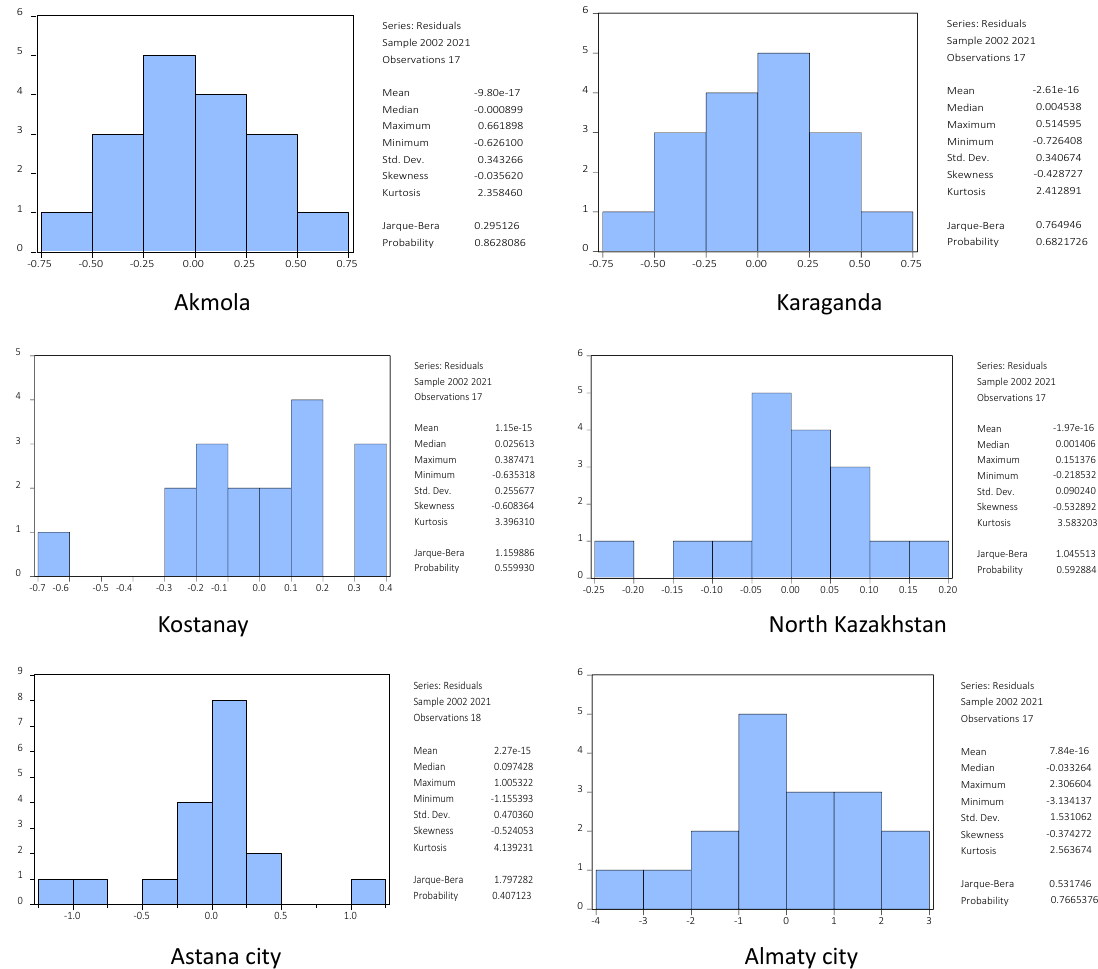
Figure 2. Estimated indicators of normal distribution